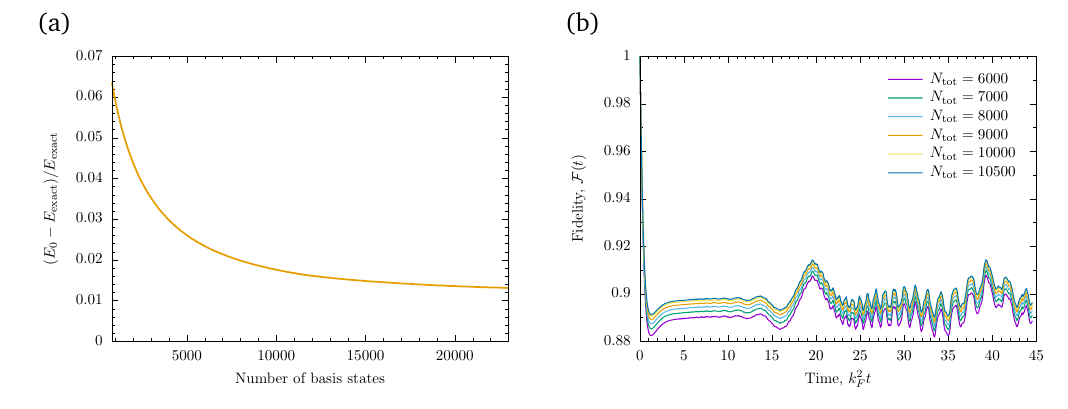
Figure 16: Example calculation showing (a) the energy convergence of the initial state; (b) the time evolution of the fidelity for N = 20 particles, for the quench = 20 → c = c i f